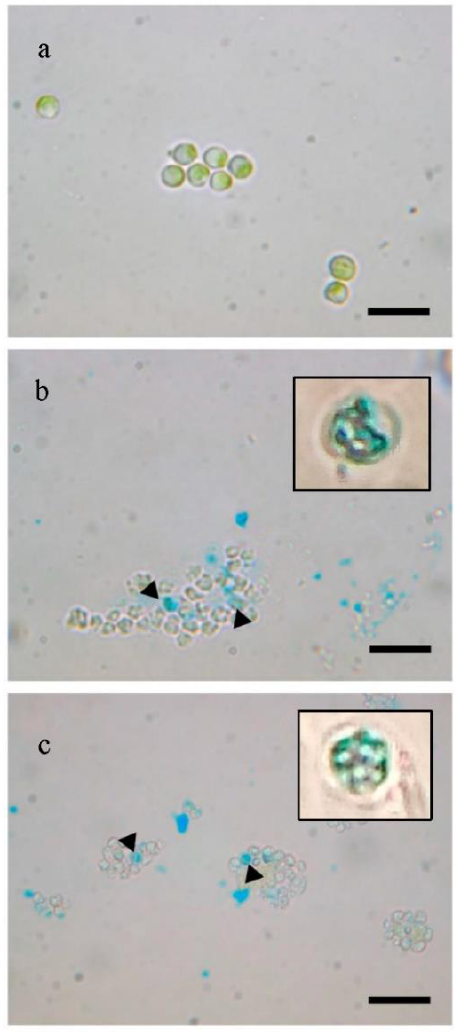
Figure 4. Visualization of the internalized magnetic iron oxide nanoparticles by light microscopy after Prussian blue staining. H. pluvialis cells were cultivated for 3 days after electroporation. ( a ) H. pluvialis untreated cells from stock culture, ( b ) H. pluvialis cells pretreated with enzyme for 8 h, ( c ) H. pluvialis cells pretreated with glass beads. In ( b , c ), a magnification of two cells stained in blue is reported, a digital zoon was used. Scale bar 10 µm.